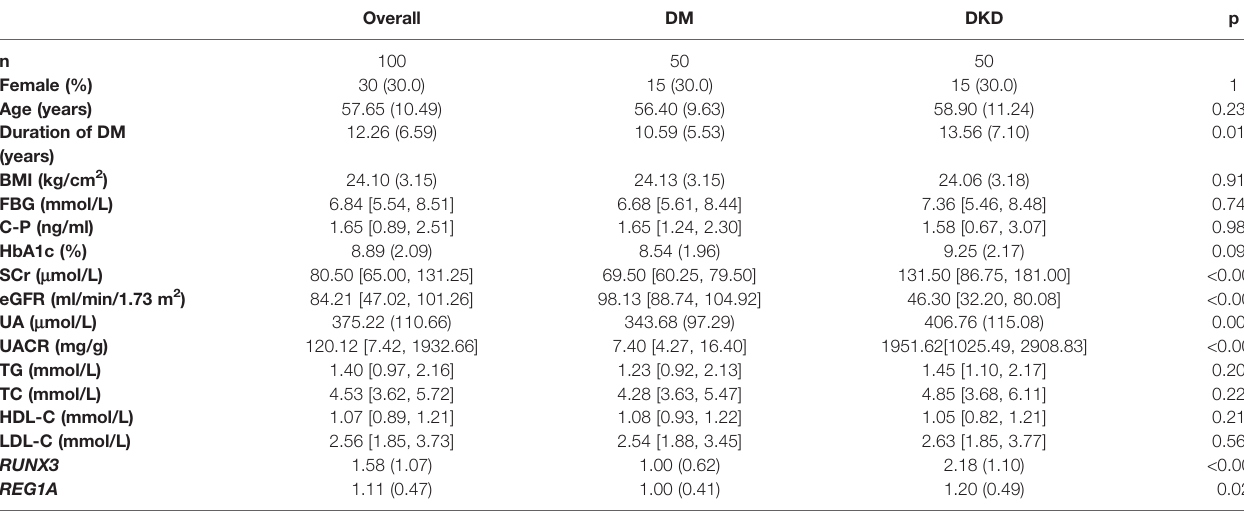
TABLE 3 | Baseline information on diagnostic markers and clinical characteristics in the DM and DKD groups. Overall DM DKD